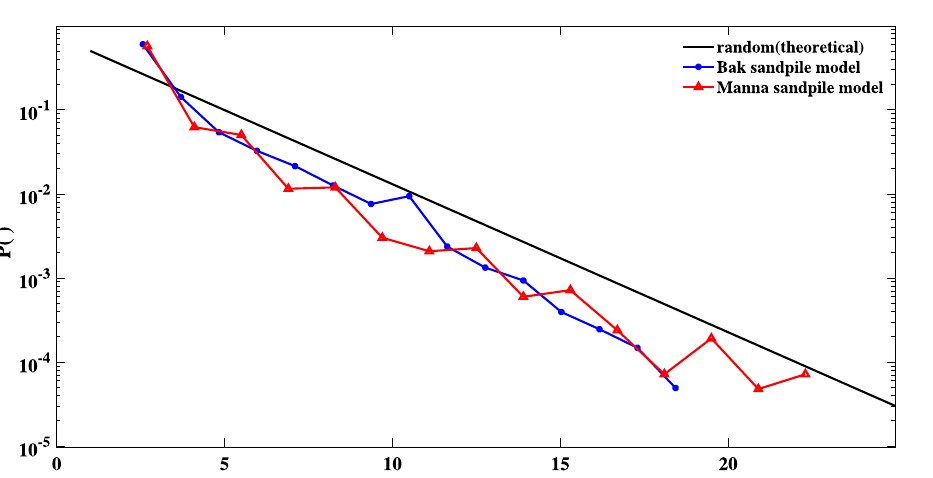
Figure 3. Semi-logarithmic presentation of degree distributions for: any random process (solid black line) which follows Eq. (5), the Bak (blue line), and Manna (red line) sand-pile